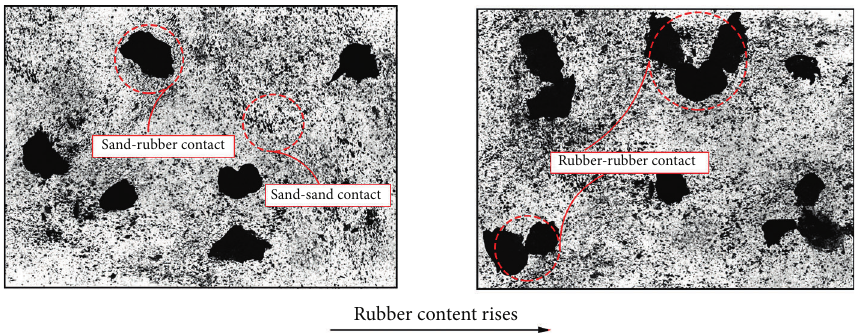
Figure 2: Contact state of particles in rubber sand (modified from